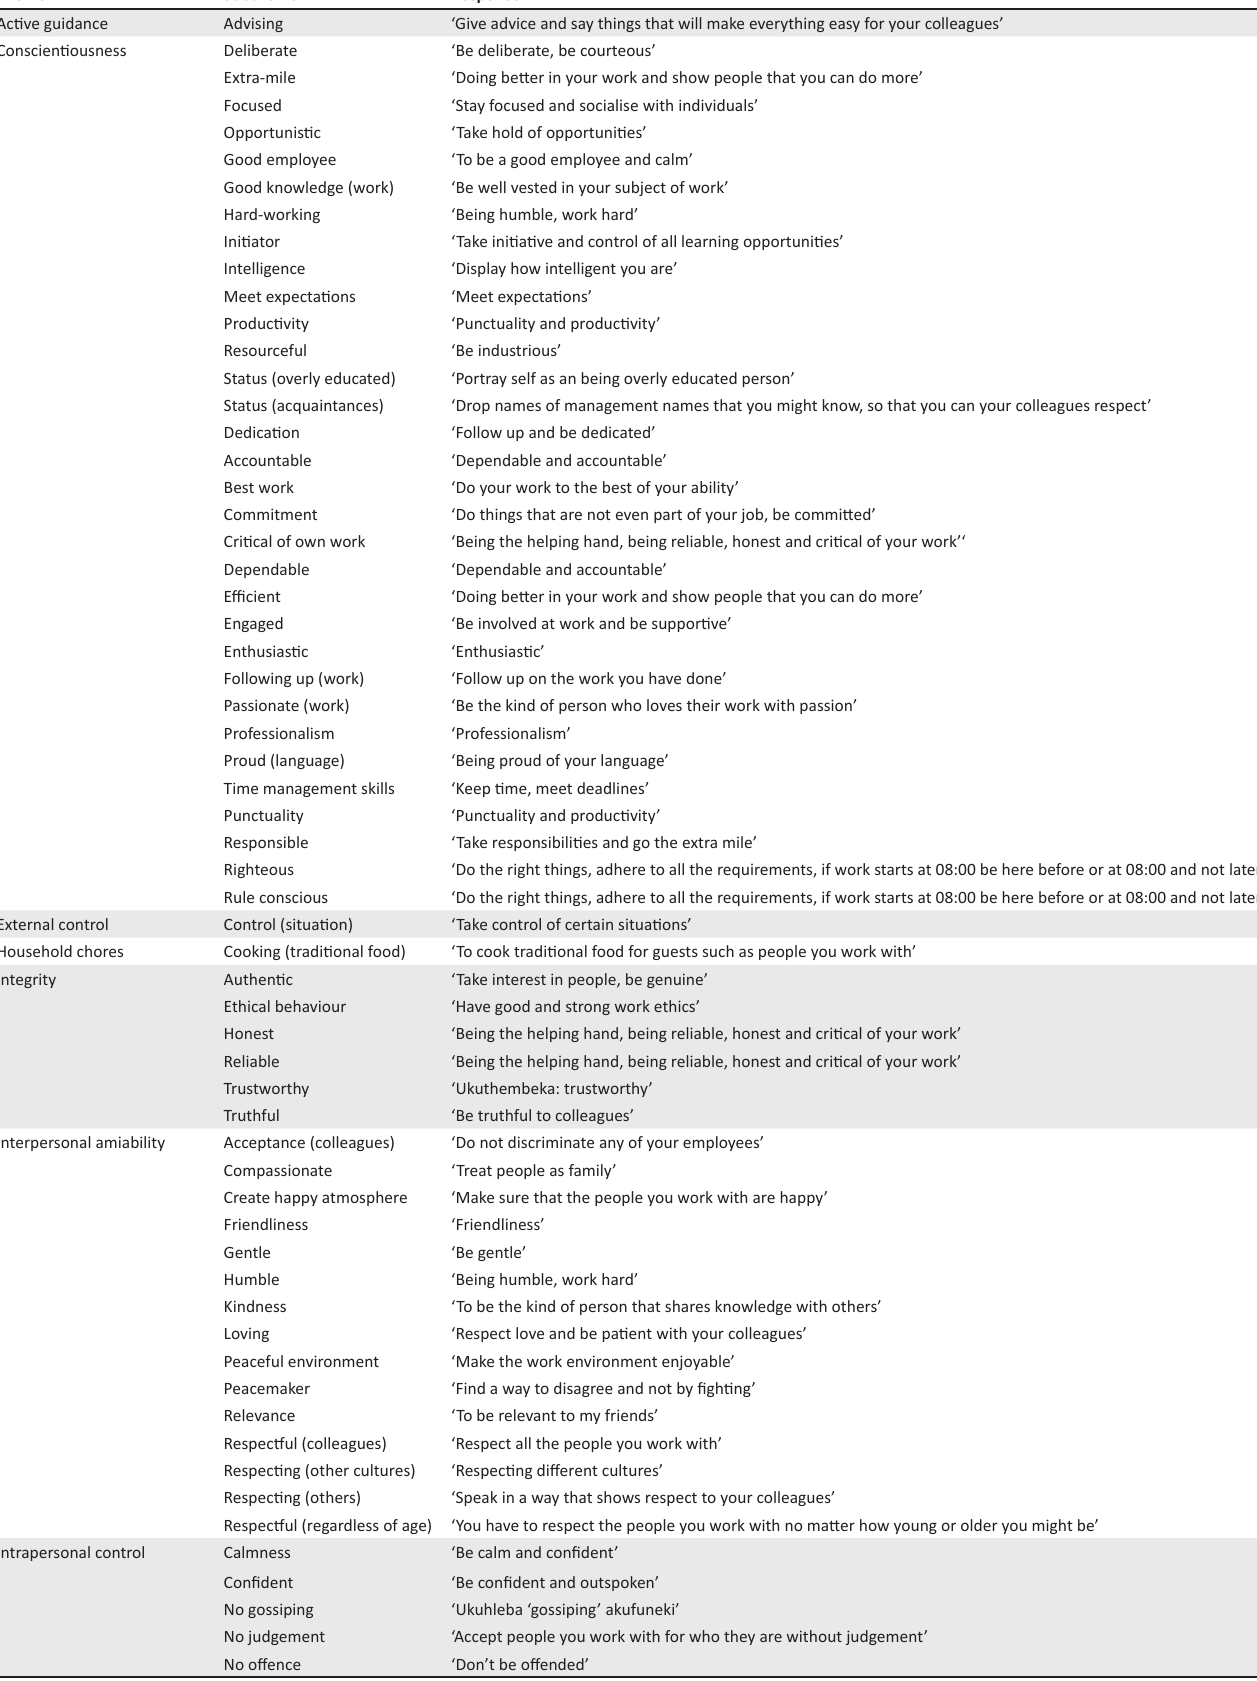
TABLE 1: Impression management features used with